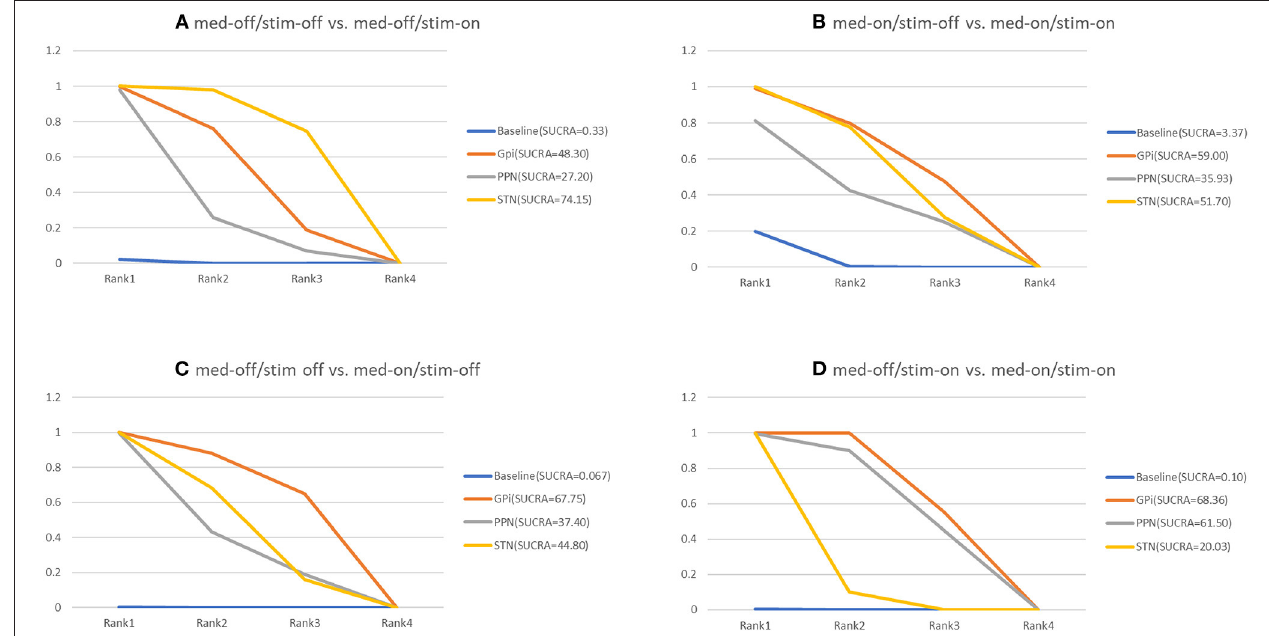
FIGURE 6 | Cumulative rank of three surgical intervention of UPDRS-III (29 item, gait); (A) med-off/stim-off vs. med-off/stim-on, (B) med-on/stim-on vs. med-on/stim-on, (C) med-off/stim-off vs. med-on/stim-off, (D) med-off/stim-on vs.